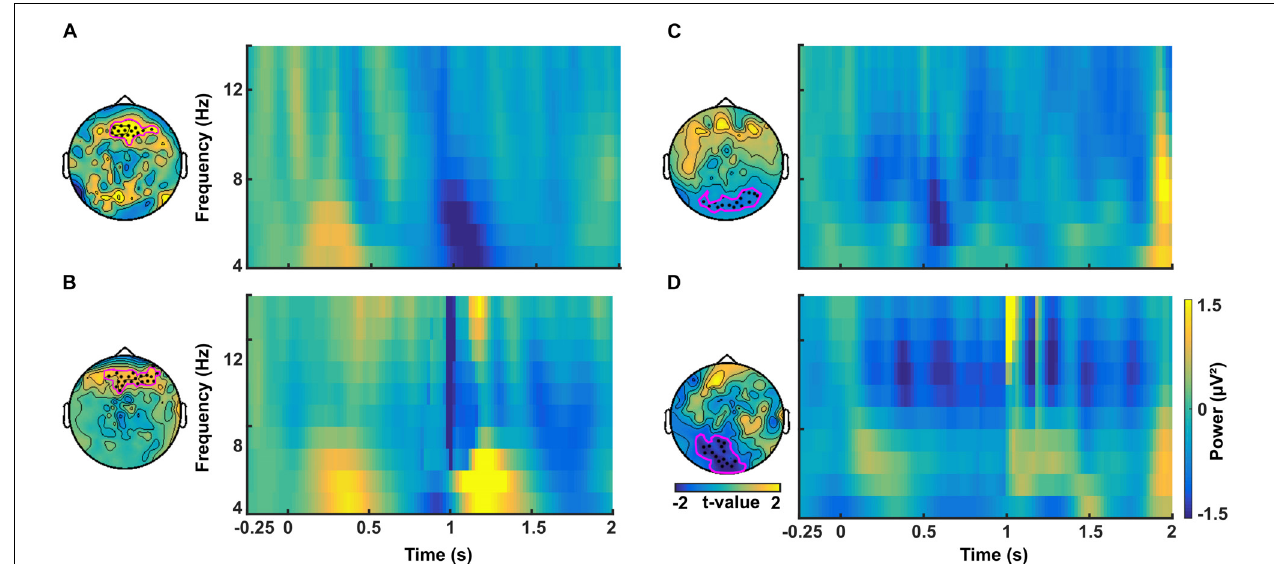
FIGURE 6 | Time-frequency plots of difference in power between CS+ and CS– averaged across channels in the theta band for (A) the no-TMS experiment and (B) the TMS experiment. In the alpha band, the time-frequency plots of difference in power between CS+ and CS– averaged across channels for (C) no-TMS experiment and (D) TMS experiment. The considered channels are indicated in each plot. These electrodes were identified with cluster-based statistics ( p < 0.05).